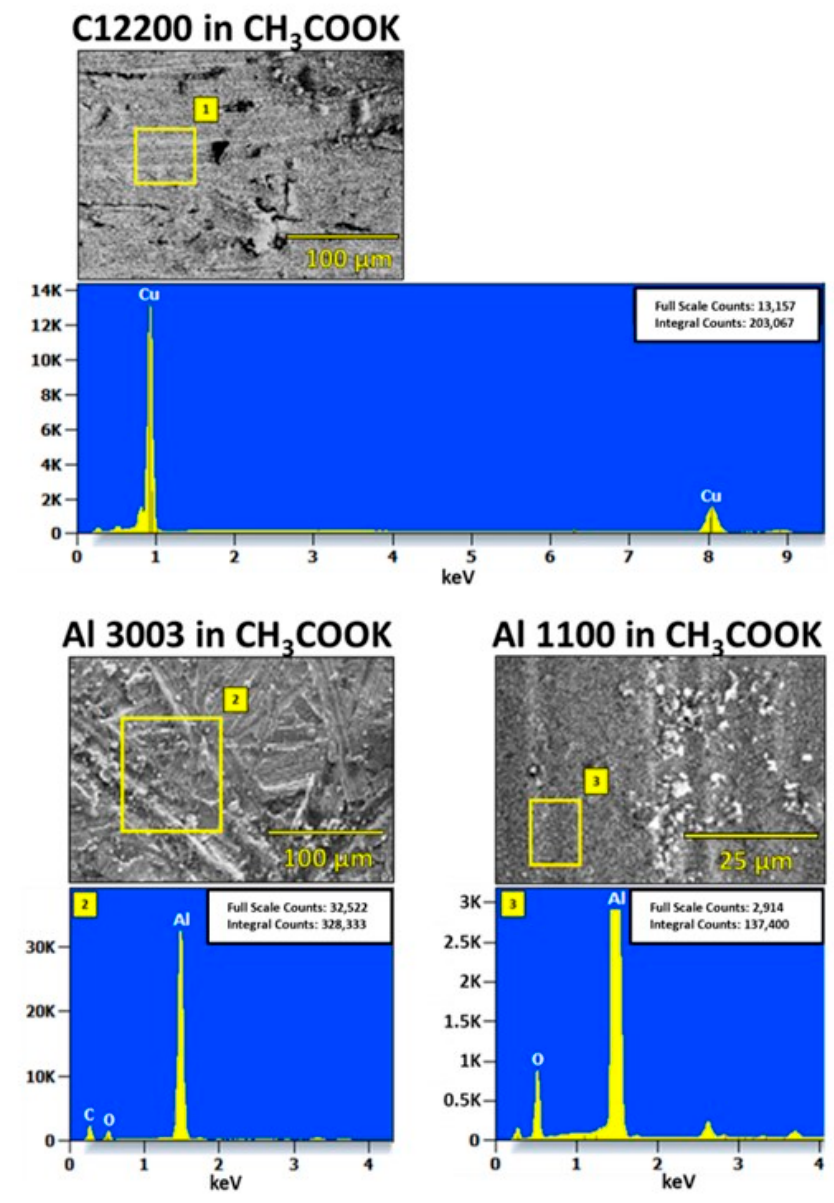
Figure 8. FESEM-EDX surface analysis of samples after electrochemical corrosion experiment in 50% CH 3 COOK solution at 80 °C.